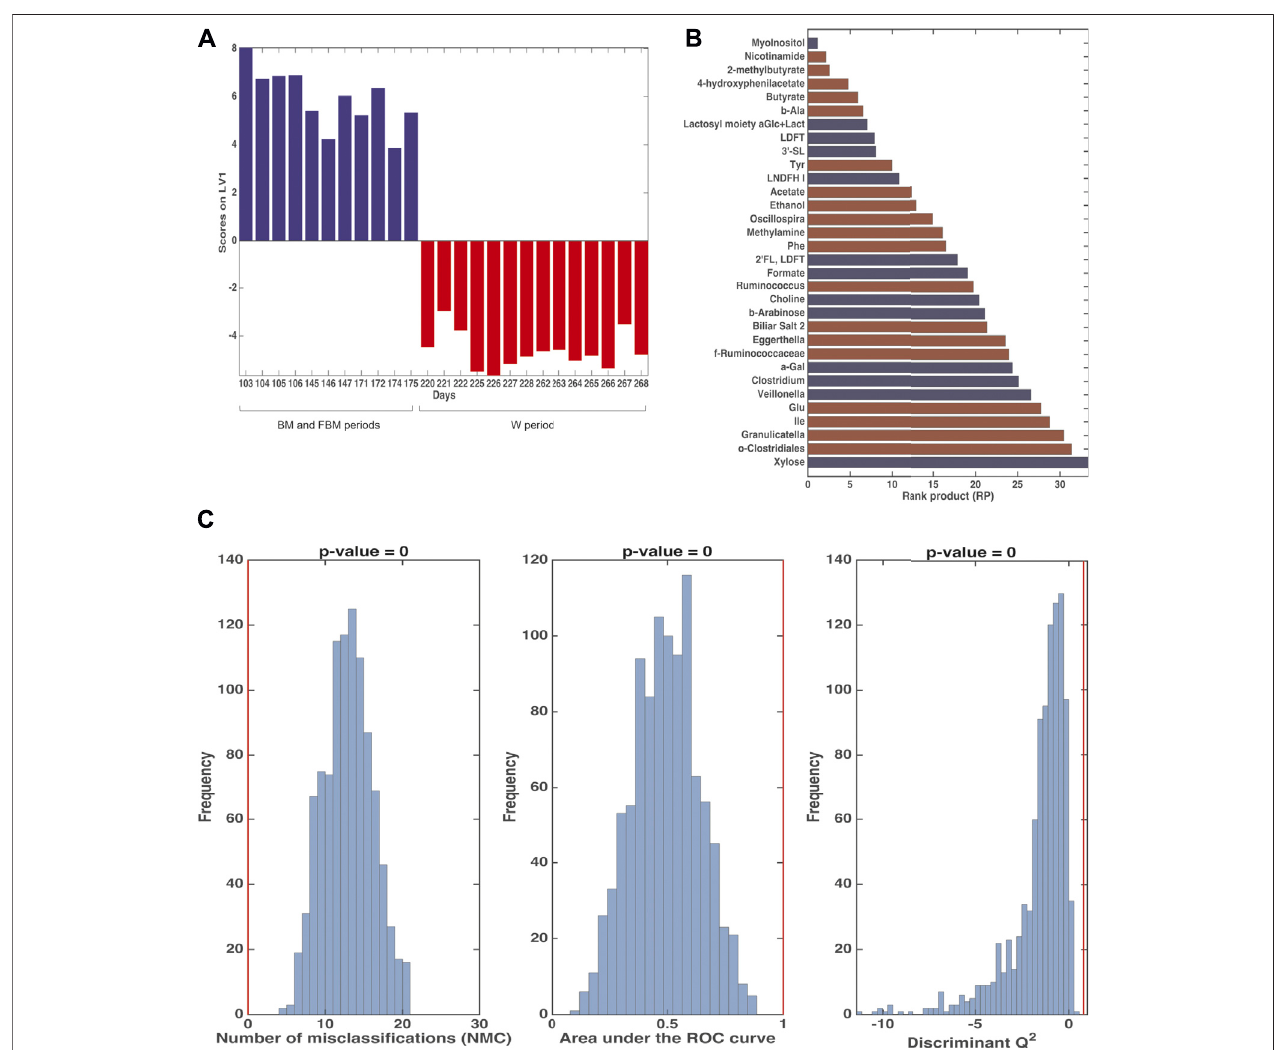
FIGURE 9 | Results of Multiblock PLS-DA in repeated Double Cross Validation for the comparison between 103 – 175 days and 220 – 268. Panel (A) : plot of the mean scores of the outer loop samples along the only latent variable of the model (LV1). Blue: 103 – 175 days; red: 220 – 268 days. Panel (B) : signi fi cant variables for the PLS-DA model by means of the rank product (RP). The criterion RP < average RP was used to identify the potential markers, which are the ones displayed as bar plot in the panel. Blue: values higher in samples collected at 103 – 175 days; red: values higher in samples collected at 220 – 268 days. Panel (C) : validation of the PLS-DA model. The fi gures of merit namely Number of Misclassi fi cations (NMC), Area Under the ROC curve and Discriminant Q 2 , calculated on the outer cross-validation loop (red vertical bars) are compared to their respective distribution under the null hypothesis (estimated by means of permutation test), indicating that the discrimination observed is statistically signi fi